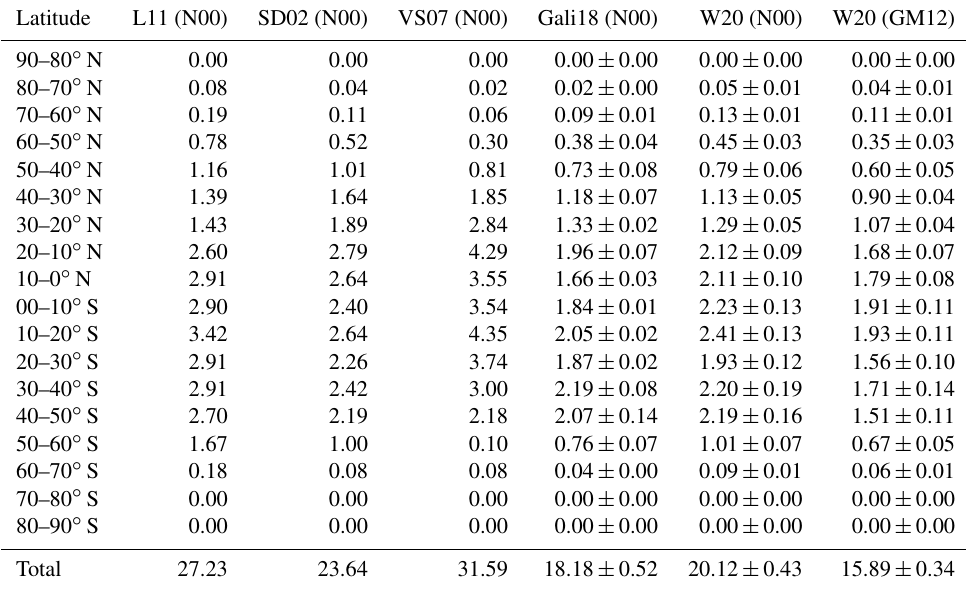
Table 2. Annually averaged zonal mean DMS flux (TgSyr − 1 ) for this study (W20), Lana et al. (2011) (L11), Simó and Dachs (2002)(SD02), Vallina and Simó (2007) (VS07), and Galí et al. (2018) (Gali18) for their four parameterization models. L11, SD02, VS07, and Gali18 are computed with the Nightingale et al. (2000) parameterization of the piston velocity (N00). Flux in this study is calculated using both the Nightingale et al. (2000) (N00) and the Goddijn-Murphy et al. (2012) (GM12) parameterizations. Uncertainties are estimated based on the top 10 models with different parameterizations. Error bars correspond to ± 1 σ